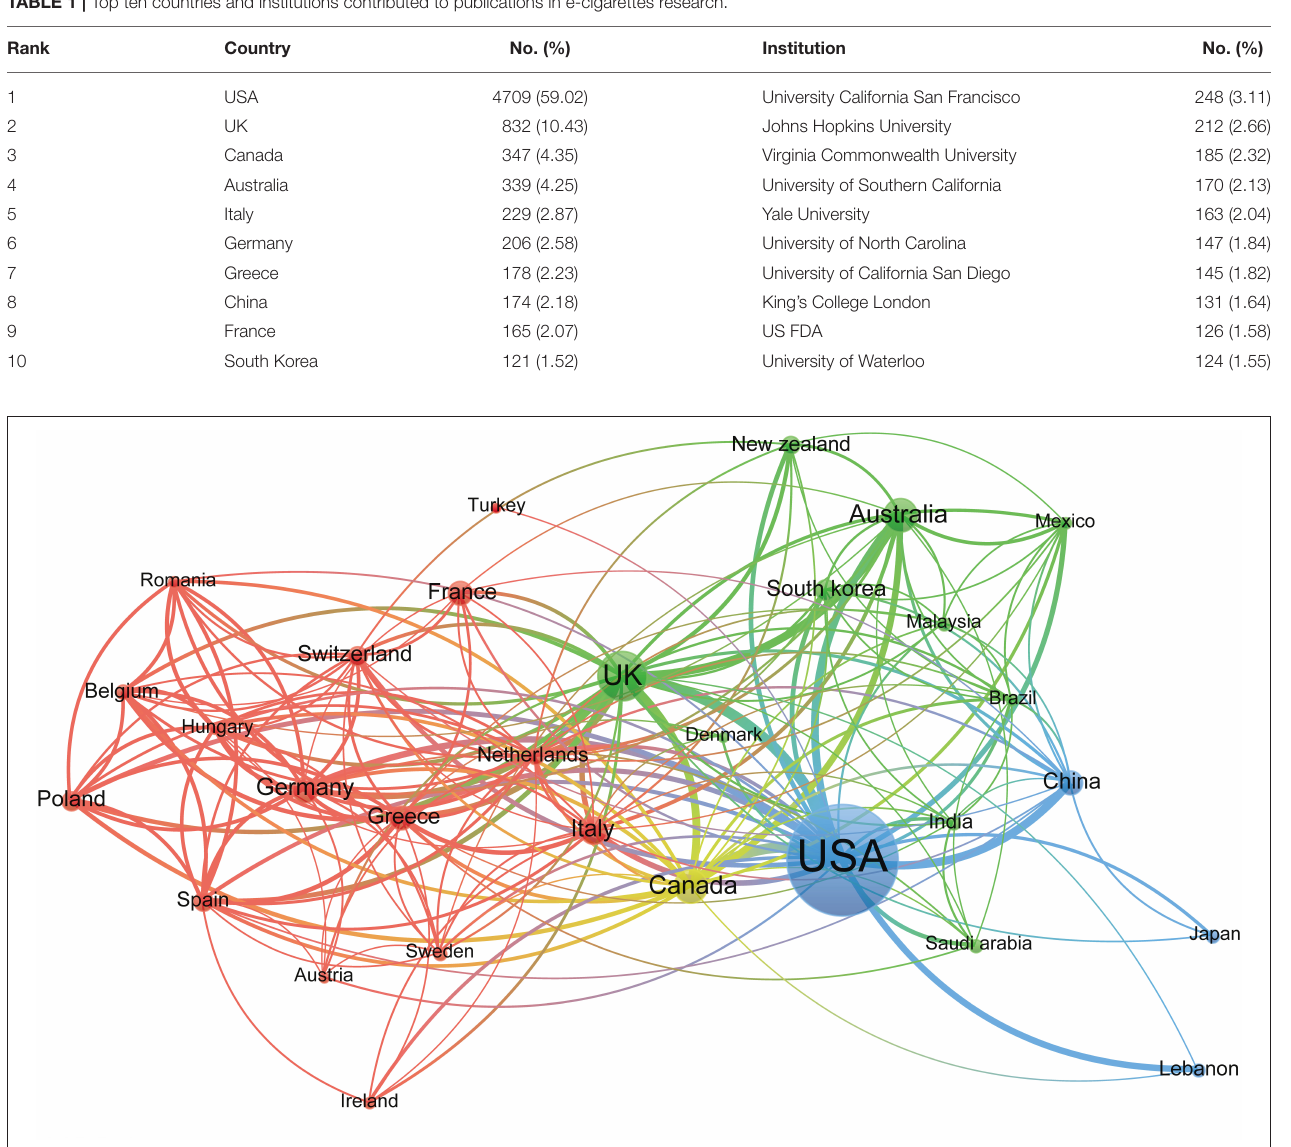
TABLE 1 | Top ten countries and institutions contributed to publications in e-cigarettes research.